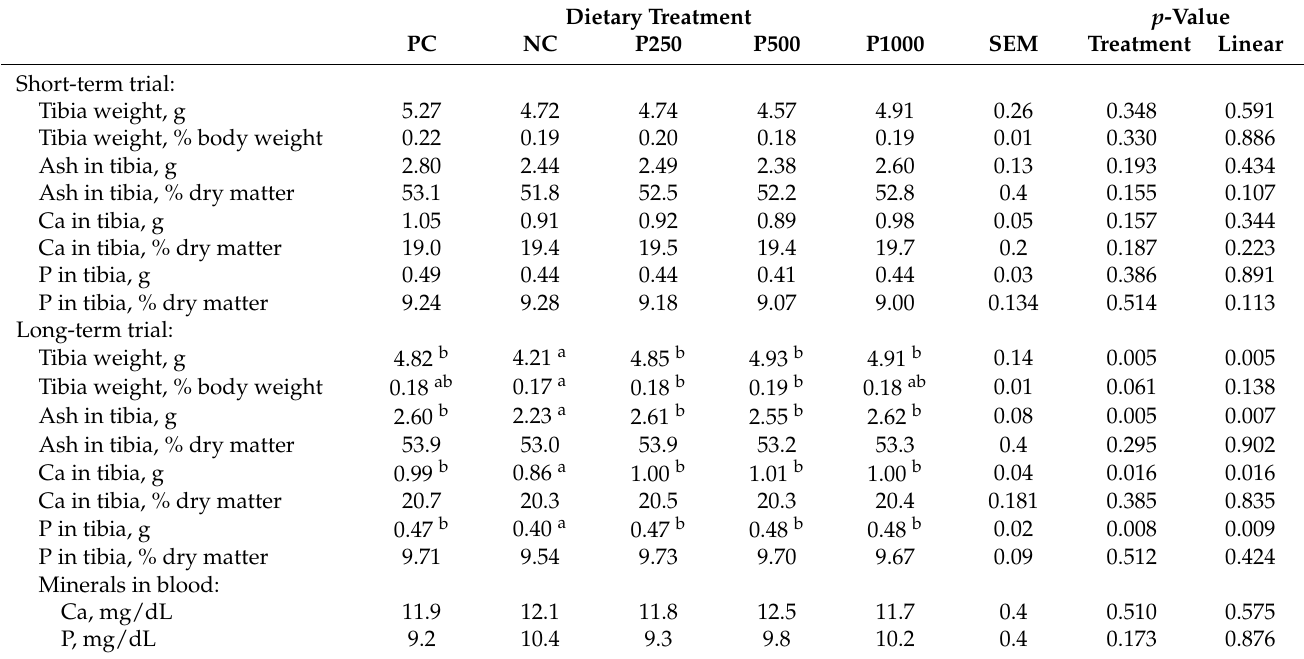
Table 5. Effect of mineral level and dietary phytase inclusion on bone mineralization traits and blood concentration of calcium (Ca) and phosphorus (P) of broilers in both short- (at 38 days of age after 17 days of treatment) and long-term trials (at 38 days of age after 38 days of treatment). Dietary Treatment p -Value PC NC P250 P500 P1000 SEM Treatment